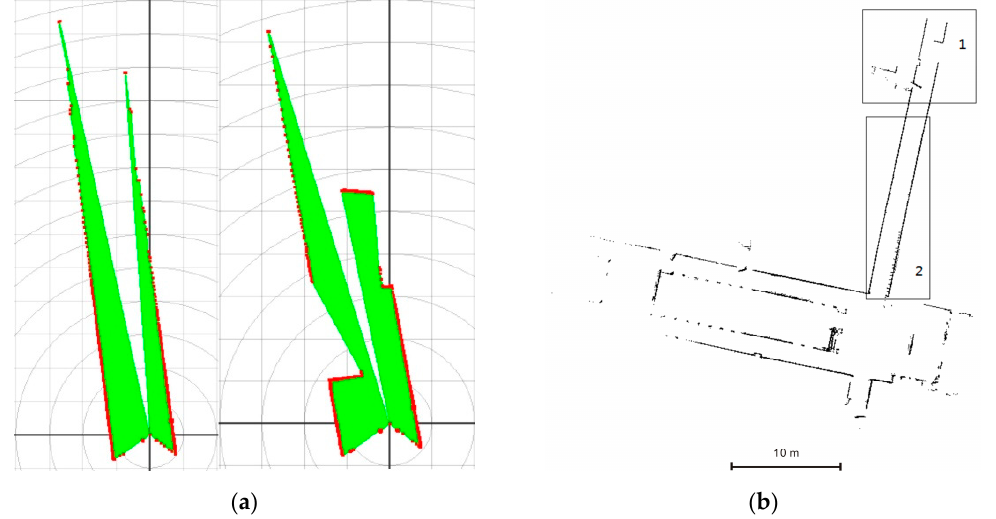
Figure 15. ( a ) The left scenario is a corridor without frontal obstacles, and the right scenario is a corridor with frontal obstacles; ( b ) matching result for scans from a long narrow corridor, with frontal obstacles in rectangle 1 and few frontal obstacles in rectangle 2.